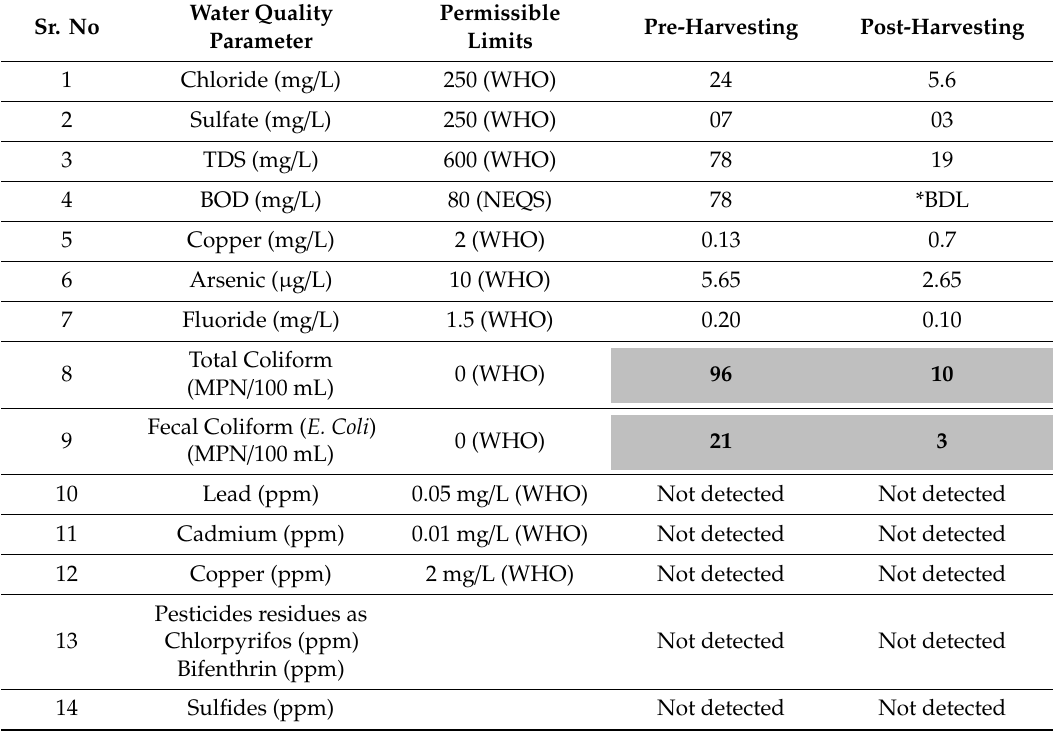
Table 6. Pre- and post-harvesting water quality comparison of the Gaddafi Stadium ponding site. Water Sr. No